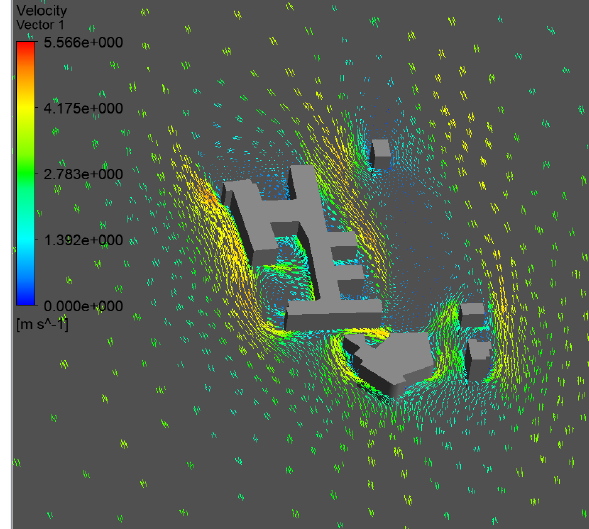
Figure 7. Example of wind velocity at pedestrian level for a building block in Stuttgart. ABL: 1 . 5 m/s at 10 m